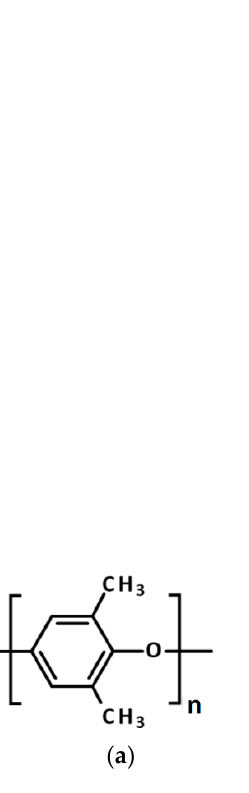
Figure 1. A schematic representation of ( a ) the hollow-fiber membrane module and ( b ) the crossflow evaluation set-up. Layer-by-Layer (LbL) and cross-linking treatments were performed inside the hollow-fiber module.